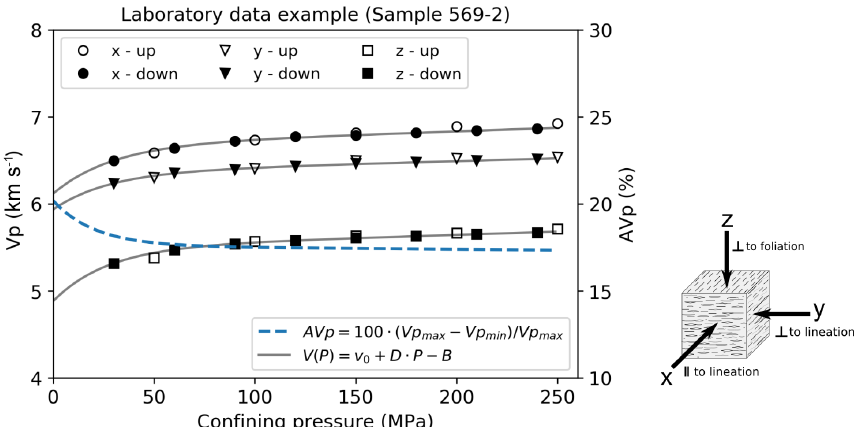
Figure 6. Data example showing confining pressure versus P-wave velocity (Vp) and anisotropy (AVp) for sample 569-2 (see Table 2). Open symbols refer to measurements during pressurization and filled symbols to measurements during depressurization. Different markers indicate the velocities measured in the respective x , y , and z core plugs along the corresponding structural axes (see also Fig. 5 and text for details).